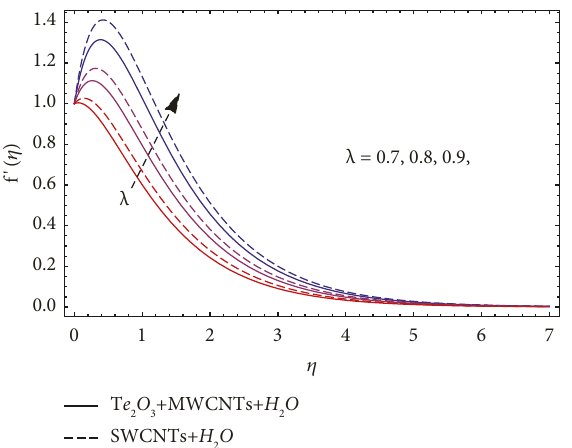
Figure 7: Influence of magnetic field parameter on velocity profile in y